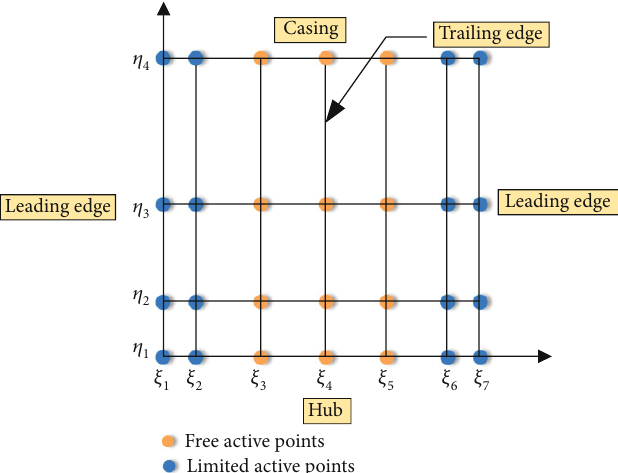
Figure 2: Schematic diagram of the point distribution of the full-blade parametric method.